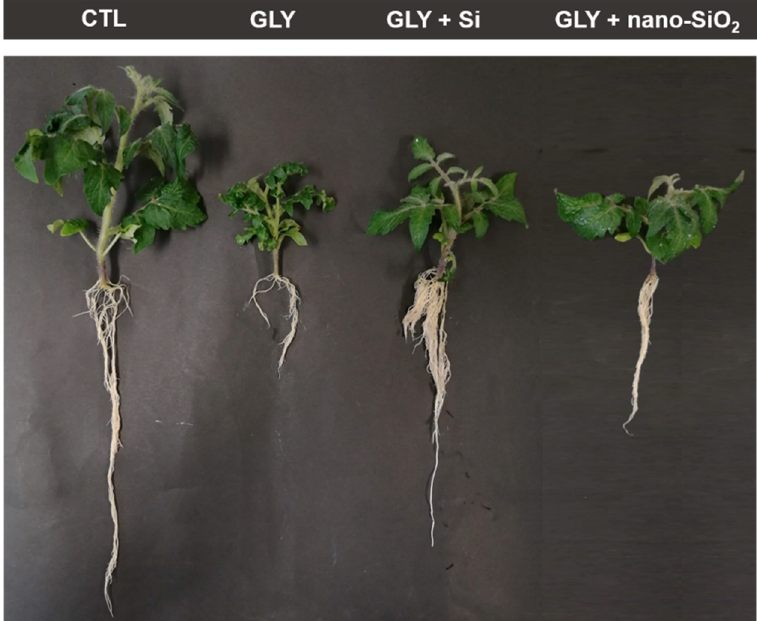
Figure 2. S. lycopersicum plants after four weeks of growth (CTL—control plants; GLY—plants exposed to GLY alone; GLY + Si—plants exposed to GLY and treated with Si; GLY + nano-SiO 2 —plants exposed to GLY and treated with nano-SiO 2 ).